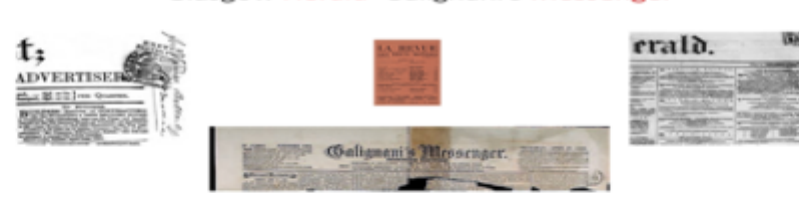
Fig. 3 Further mastheads of newspapers and